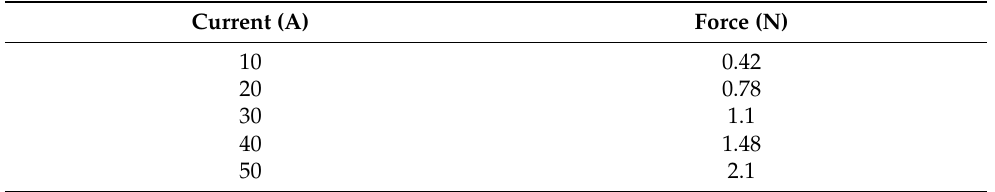
Table 1. Experimental data on electromagnetic force and current.